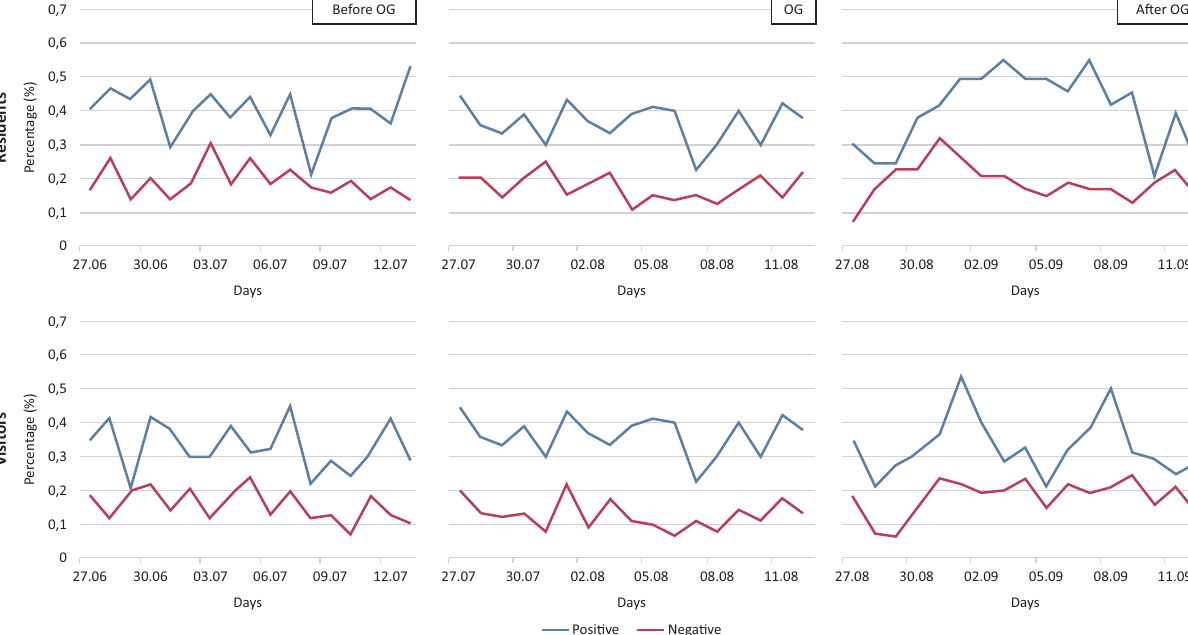
Figure 8. Daily sentiment analysis distribution for residents and visitors for the “transportation” topic (percentage of total number of tweets in the given temporal bin for the respective